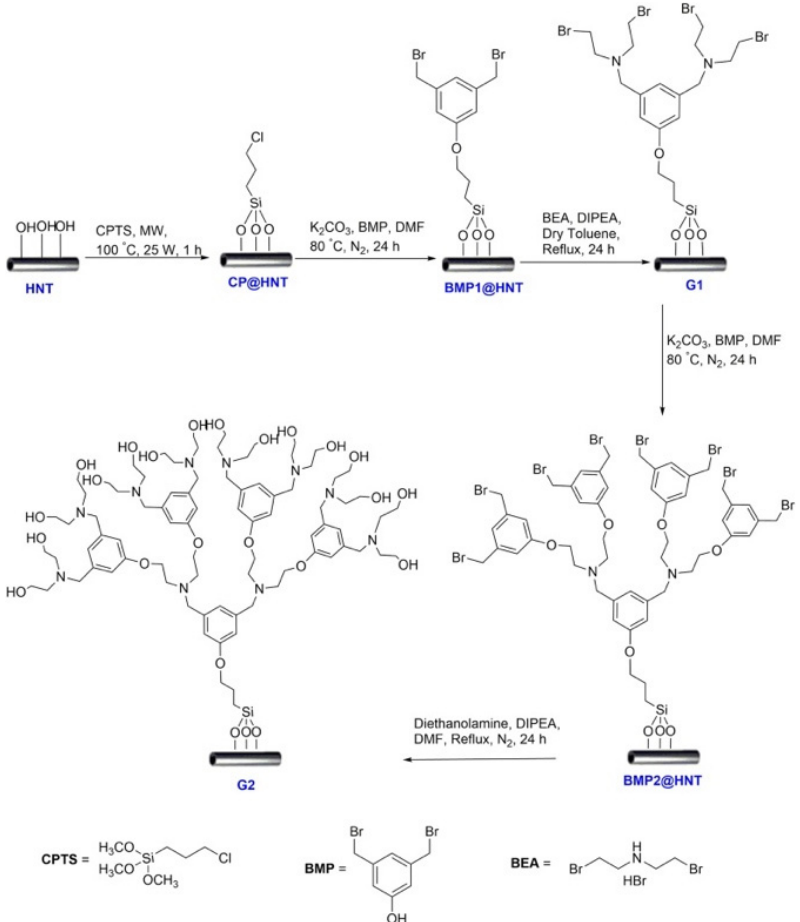
Figure 8. Schematic representation of the dendrimers supported onto HNTs. Reproduced with permission from ref. [95]. Copyright 2020 John Wiley and